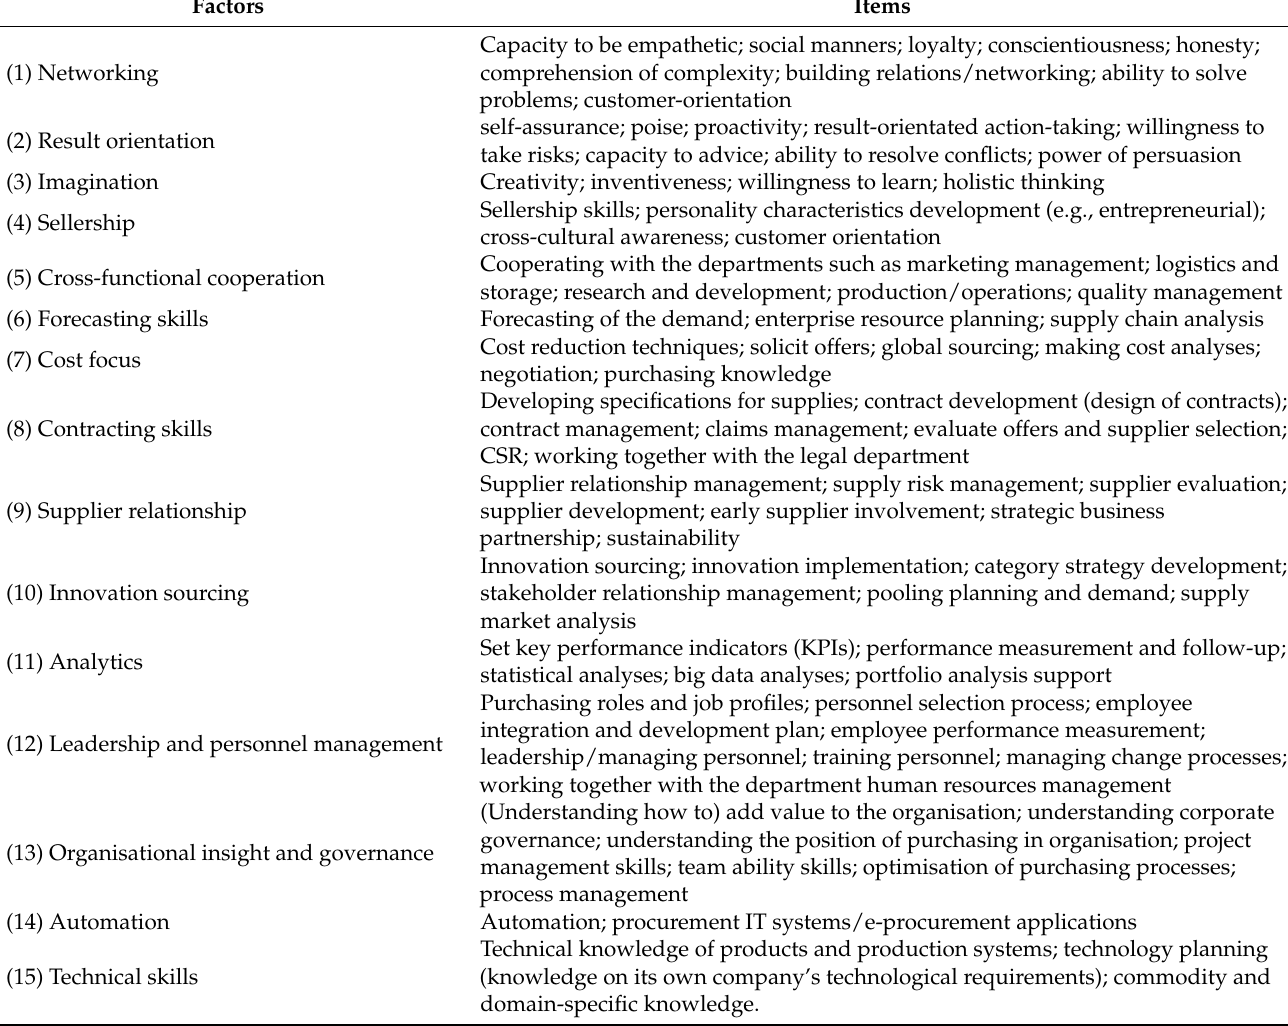
Table 2. PSM skills taxonomy [11] (p.